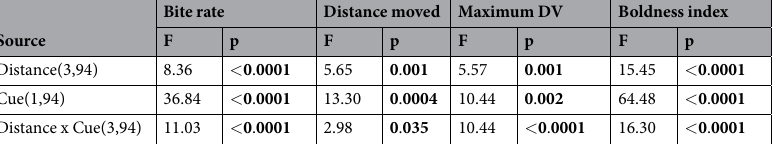
ness index (Fig. 3d, Table 2) when on live coral (as indicated by the significant interactions: Cue x State). This suggests that the 20–40 min time period spent habituating on the live coral prior to being retested was sufficient for them to recover their ability to identify their alarm odour as a threat. Total distance moved and mean dis- tance ventured (DV) had similar trends to bite rate, but showed more variability and non-significant interac- tions (p = 0.053 and p = 0.075 respectively; Fig. 3c,d, Table 2). While these behaviours displayed a more variable response to alarm odour when fish were on dead coral, both species showed much lower distances moved and ventured when exposed to alarm odours on live coral (Table 2, Fig. 3b,c). Effect of water source on alarm response. The substratum within the header tank (i.e.water source) affected whether the Ambon damselfish responded to alarm odours (feeding rate, Source x Cue: F 7,256 = 5.407, p < 0.001; line crosses, Source x Cue: F rates (except dead-scrubbed coral) in response to the introduction of alarm odour compared to when seawater was